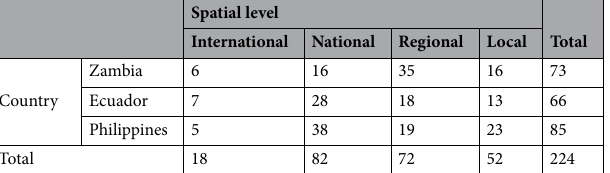
Table 1. Number of interviews conducted per country and spatial level of the participants’